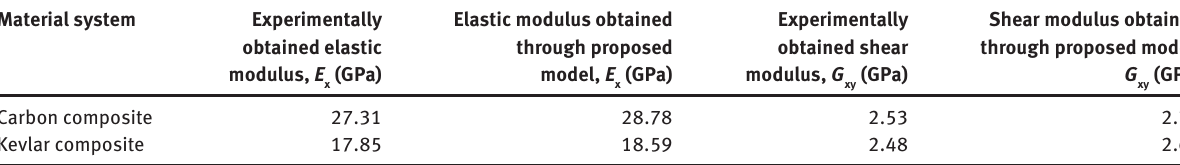
Table 7: Comparison of experimental and computational results. Material